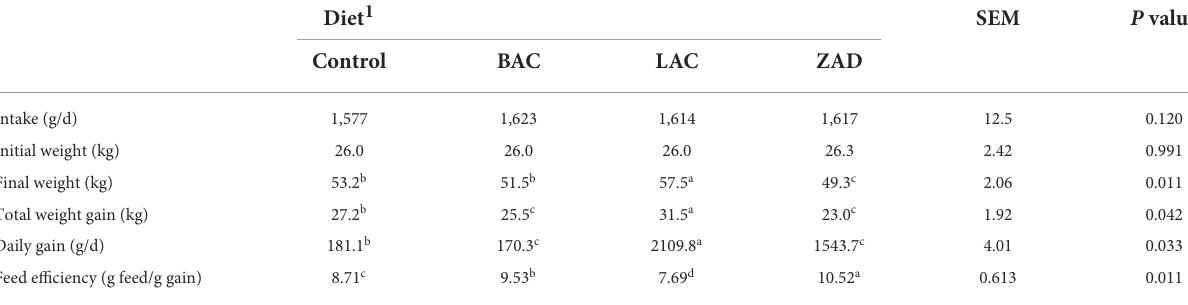
TABLE 2 Feed intake, growth performance, and feed efficiency of growing Farafra lambs fed diets containing date palm leaves treated with different